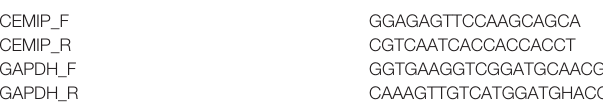
TABLE 2 | The Sequences of the mRNA